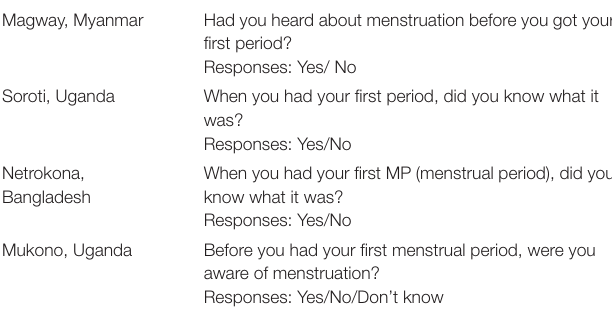
TABLE 1 | Survey questions used to assess knowledge of menstruation at menarche. Magway, Myanmar Had you heard about menstruation before you got your first